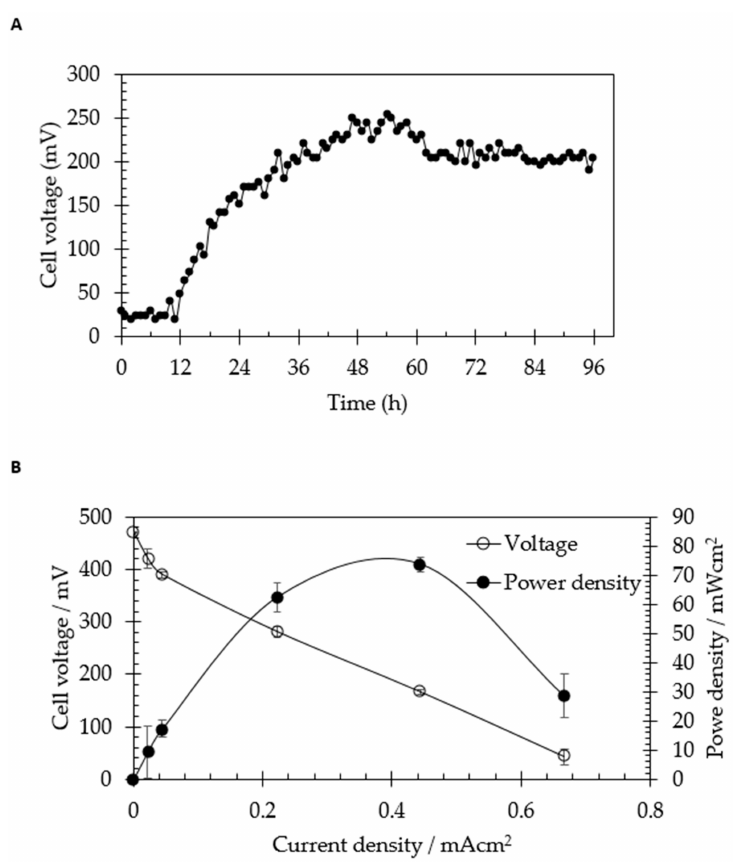
Figure 3. Bioelectricity generation from sago hampas by Clostridium beijerinckii SR1. ( A ) Voltage generation from 20 g / L of sago hampas by C. beijerinckii SR1 as a function of time. ( B ) Power density and cell voltage generation as a function of current